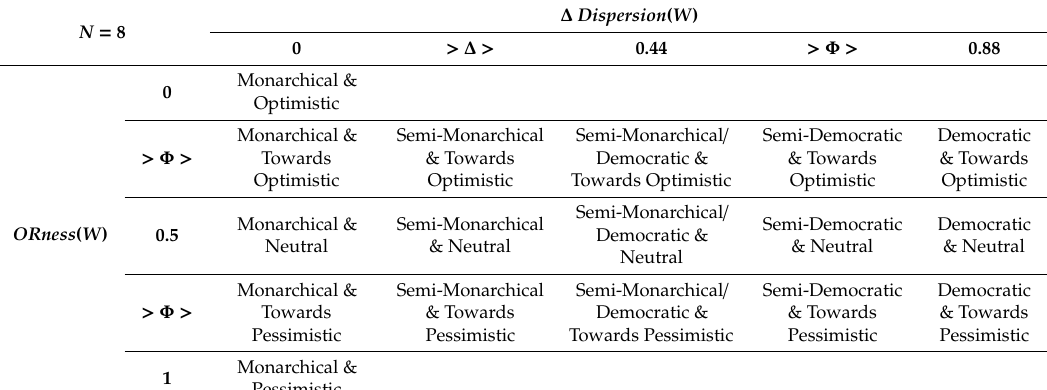
Table 4. Decision attitude as a function of ORness ( Φ and dispersion ( ∆ ) in the case of aggregation of N = 8 partial evidence degrees of critical / anomalous event /